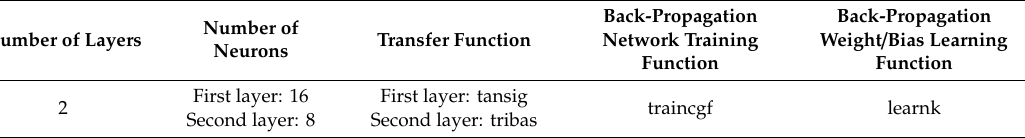
Table 1. The structure used in hybrid artificial neural network-harmony search for selecting e ff ective